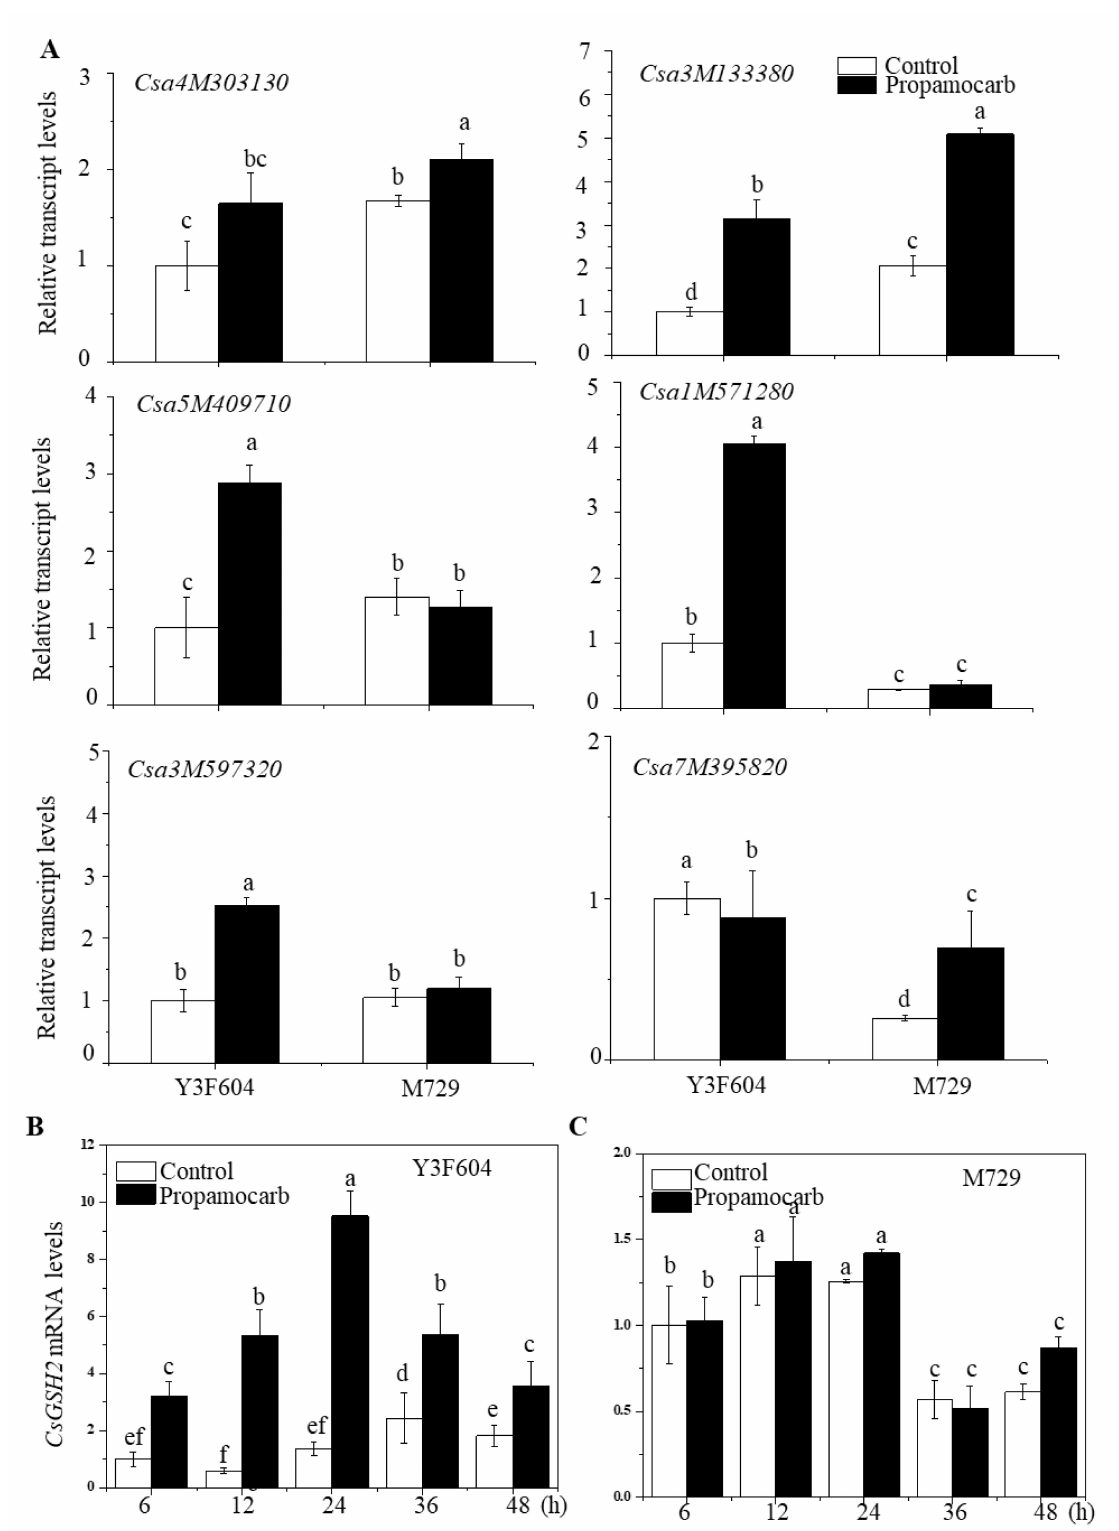
Figure 2. CsGSH2 expression analysis in cucumber under propamocarb stress. ( A ) Expression levels of six genes of the glutathione pathway. Dynamic expression of CsGSH2 in the leaves of ( B ) Y3F604 and ( C ) M729. The relative expression levels of the genes were analyzed by qRT-PCR using CsEF1 α as the reference gene. Data are the means of three replicates with SEs, and different letters indicate significant differences ( p <